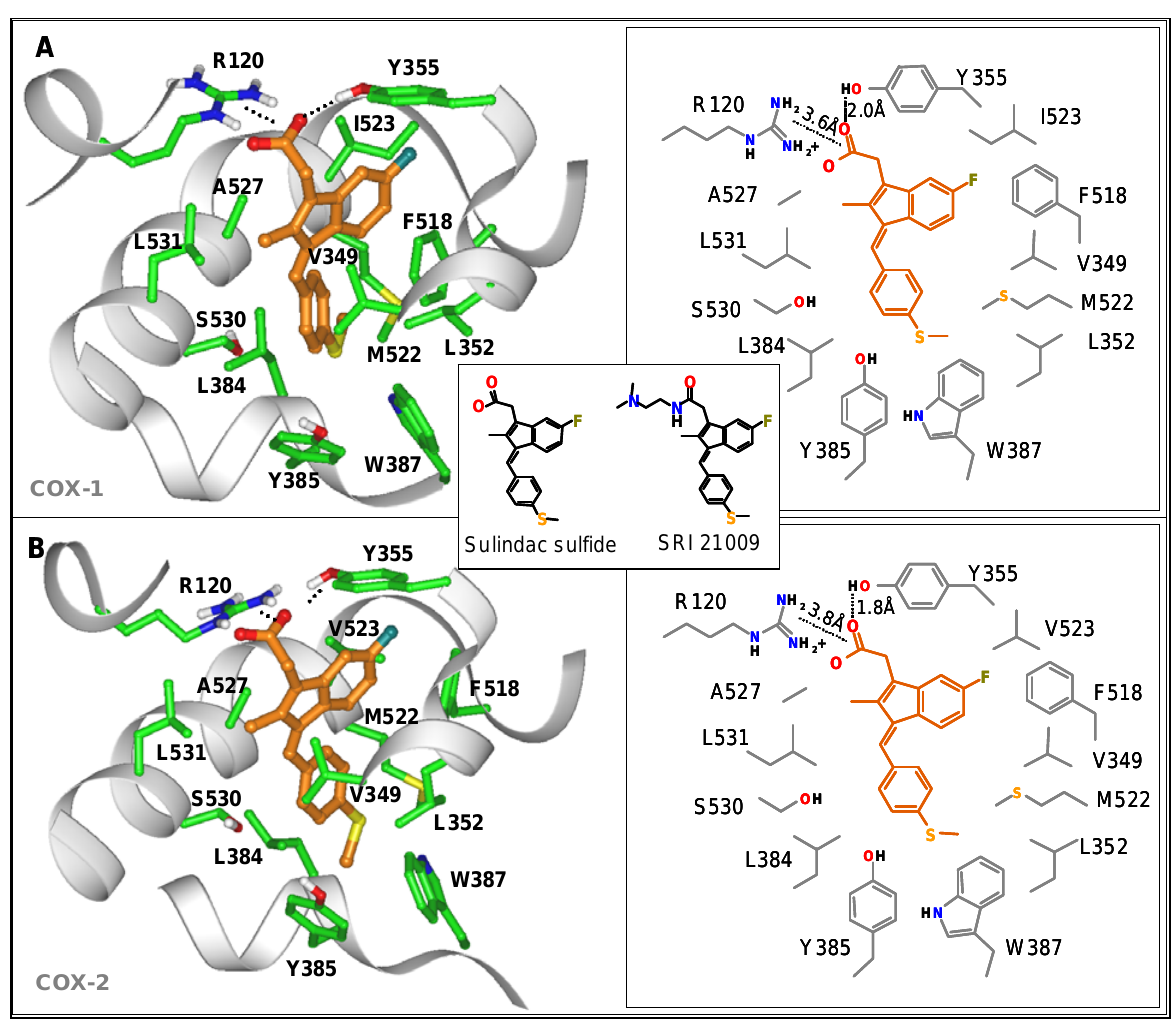
Figure 4. Molecular modeling of SS binding to COX-1 (A) or COX-2 (B). Chemical structures of SS and SRI 21009 (SSA) are shown in the insert.